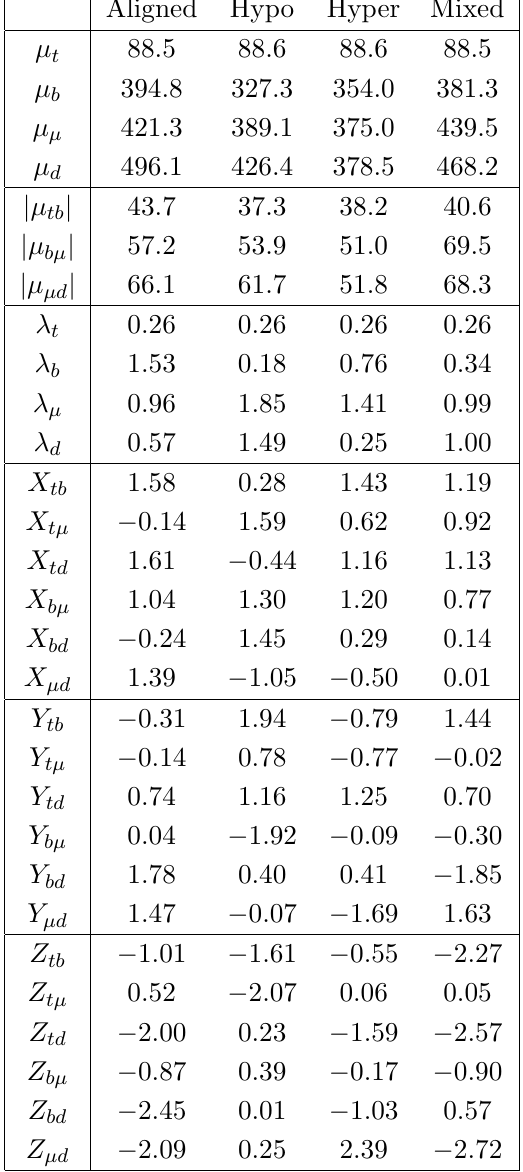
Table 2 . Four sets of numerical values giving rise to four di(cid:11)erent benchmark scenarios as discussed in the text. The (cid:22) a and (cid:22) ab parameters are in GeV while the rest have no units. All parameters have been assumed to be